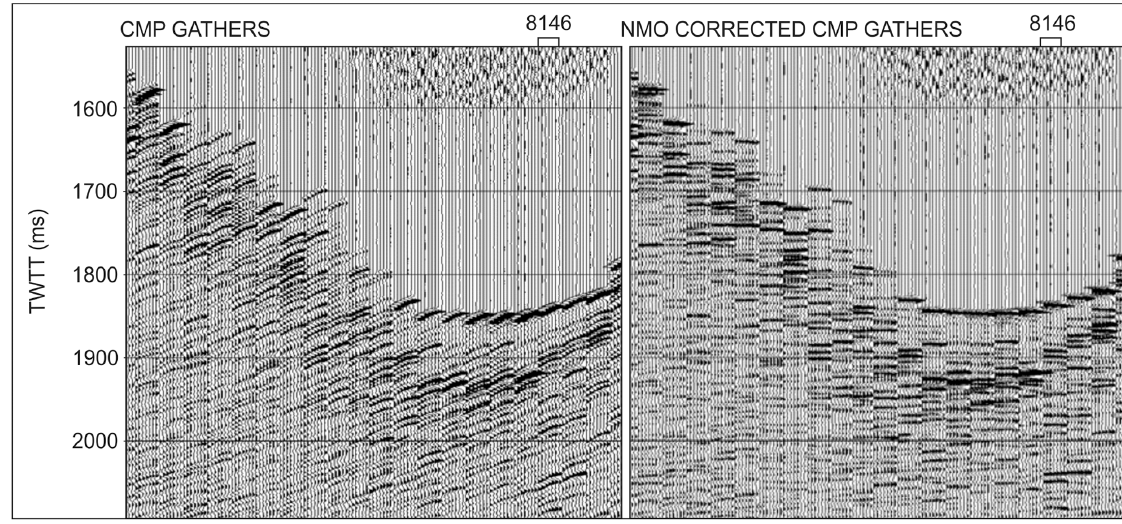
Figure 10. Uncorrected (left) and NMO corrected (right) CMP gathers extracted from the dataset of line L_T19_HR (Tyrrhenian Sea). Each CMP gather is composed of 7 traces, representing the CMP fold coverage. The quality of the velocity function can be verified by inspecting the flatness of the corrected event, that must result horizontally aligned.